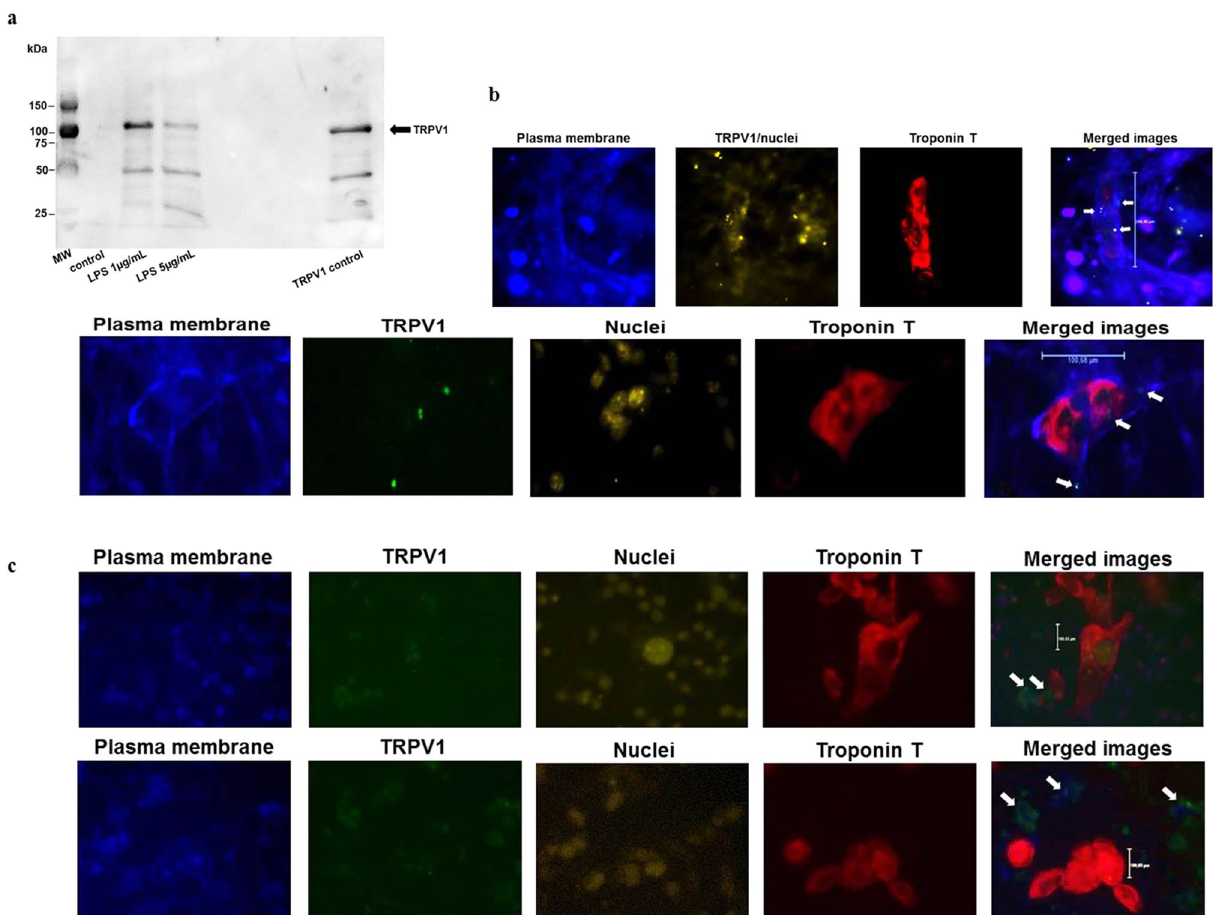
Figure 1. ( a ) Detection of TRPV1 protein in hiPSC-cardiomyocytes by western blotting. Cells were incubated with LPS for 6 h, 37 °C. Unstimulated cells served as a control (“control”). TRPV1 control protein was loaded at equal concentration. Primary antibody: rabbit polyclonal anti-TRPV1, #ACC-030, alomone labs, 1:500, 4 °C overnight. TRPV1 control: TRPV1 control peptide, #ACC-030, alomone. kDa—kiloDalton, MW—molecular weight marker. A representative experiment out of 4 independent experiments is shown. ( b ) TRPV1 is present in the plasma membrane of hiPSC-cardiomyocytes (troponin T-positive cells). Cells were stained by immunofluorescence for plasma membrane, TRPV1, troponin T and nuclei (upper panel: Alexa350-wheat germ agglutinate anti-plasma membrane, anti-TRPV1 primary/PE-anti-rabbit secondary antibody, Alexa647-anti troponin T, propidiumjodide. Lower panel: Alexa350-wheat germ agglutinate plasma membrane, anti-TRPV1 primary/ FITC-anti-rabbit secondary antibody, Alexa647-anti troponin T, propidiumjodide). Arrows in the merged images denote TRPV1. Magnification was 40x. Scale bars: Upper panel: 244.45 µm. Lower panel: 100.68 µm. Independent experiments, n = 3. Per experiment, images of 6–16 different positions were taken. ( c ) TRPV1 is present in the plasma membrane of cell types other than cardiomyocytes (troponin T-negative cells). Cells were stained by immunofluorescence as in Figure ( b ), lower panel. Arrows in the merged images denote TRPV1 in cells other than hiPSC-CMs. Magnification was 40 × . Scale bars: 100.03 µm. Independent experiments, n = 3. Per experiment, images of 6–16 different positions were